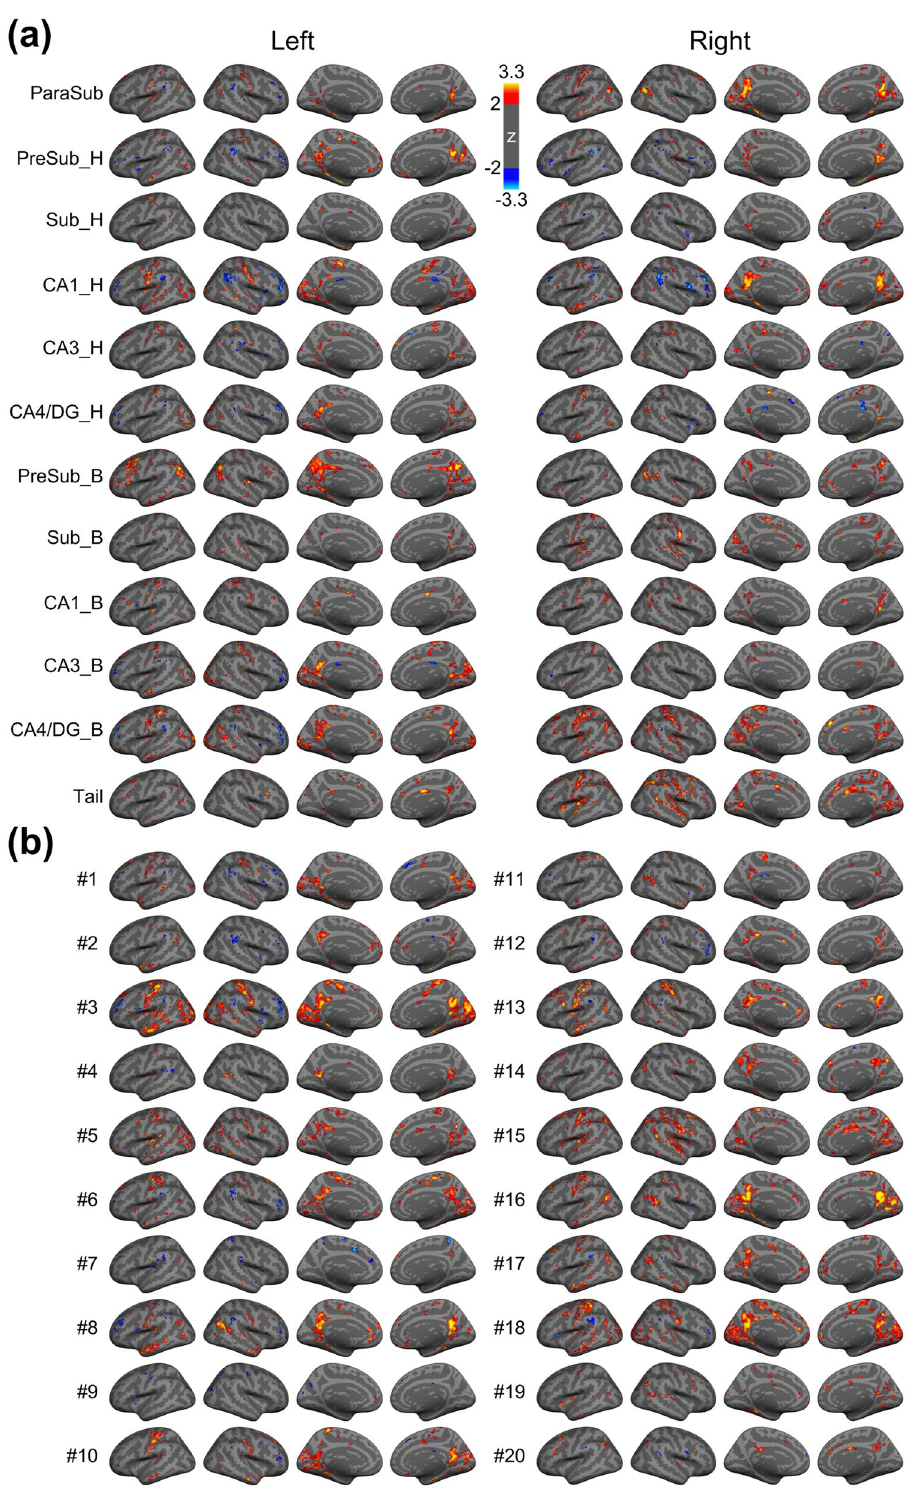
Figure 3. Whole brain functional connectivity maps using ( a ) aHPSFs and ( b ) fHPSFs as seed regions, respectively. The statistical significances of iFC maps were assessed using a vertex-wise non-parametric permutation test with 4000 permutations. The statistical maps of iFC were corrected for multiple comparisons and cluster-wise threshold set to p < 0.05. The z scores are color-encoded as indicated by the color bar. H head; B body; Sub subiculum; CA cornu ammonis; DG dentate